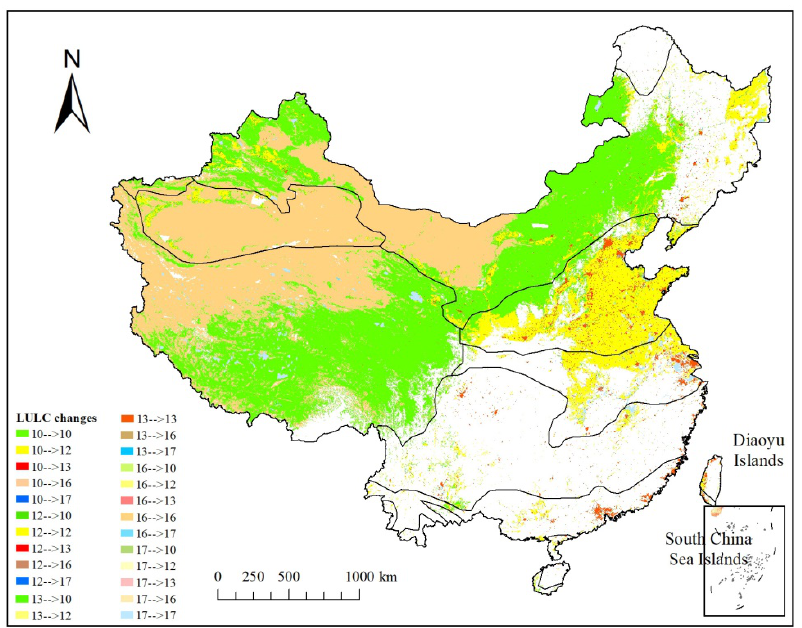
Figure A4. Distribution map of LULC changes. Numbers 10 ‒ 17 represent grasslands, croplands, urban and built-up lands, barren land, and water bodies, respectively.